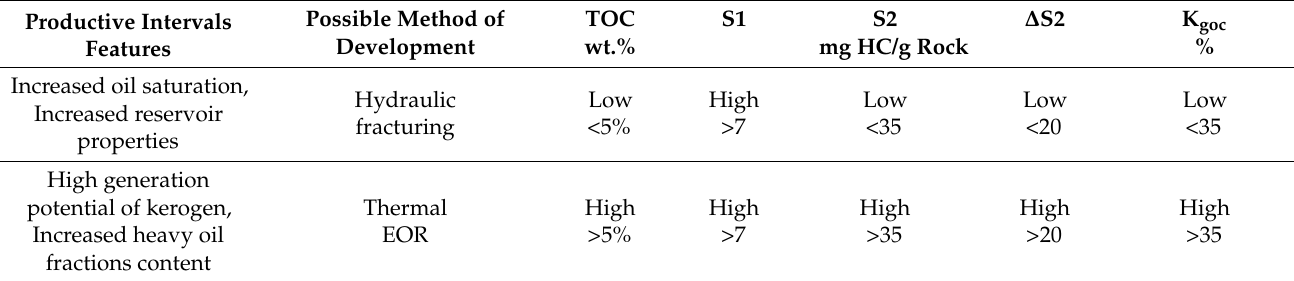
Table 2. Pyrolysis characteristics of productive intervals in the Bazhenov formation.